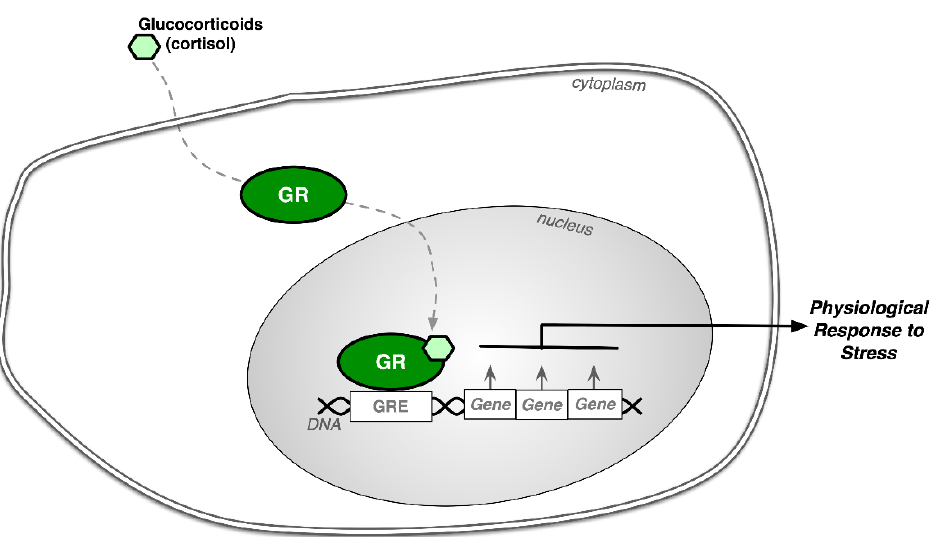
Figure 2. Cellular Response to Stress. Glucocorticoid hormones (cortisol) enter through the cell membrane to bind the glucocorticoid receptor (GR) in the cytoplasm. Cortisol-bound GR then moves to the nucleus to regulate gene expression by binding to glucocorticoid response elements (GREs) in the regulatory regions of select target genes. This signaling mechanism determines how each person responds physiologically to